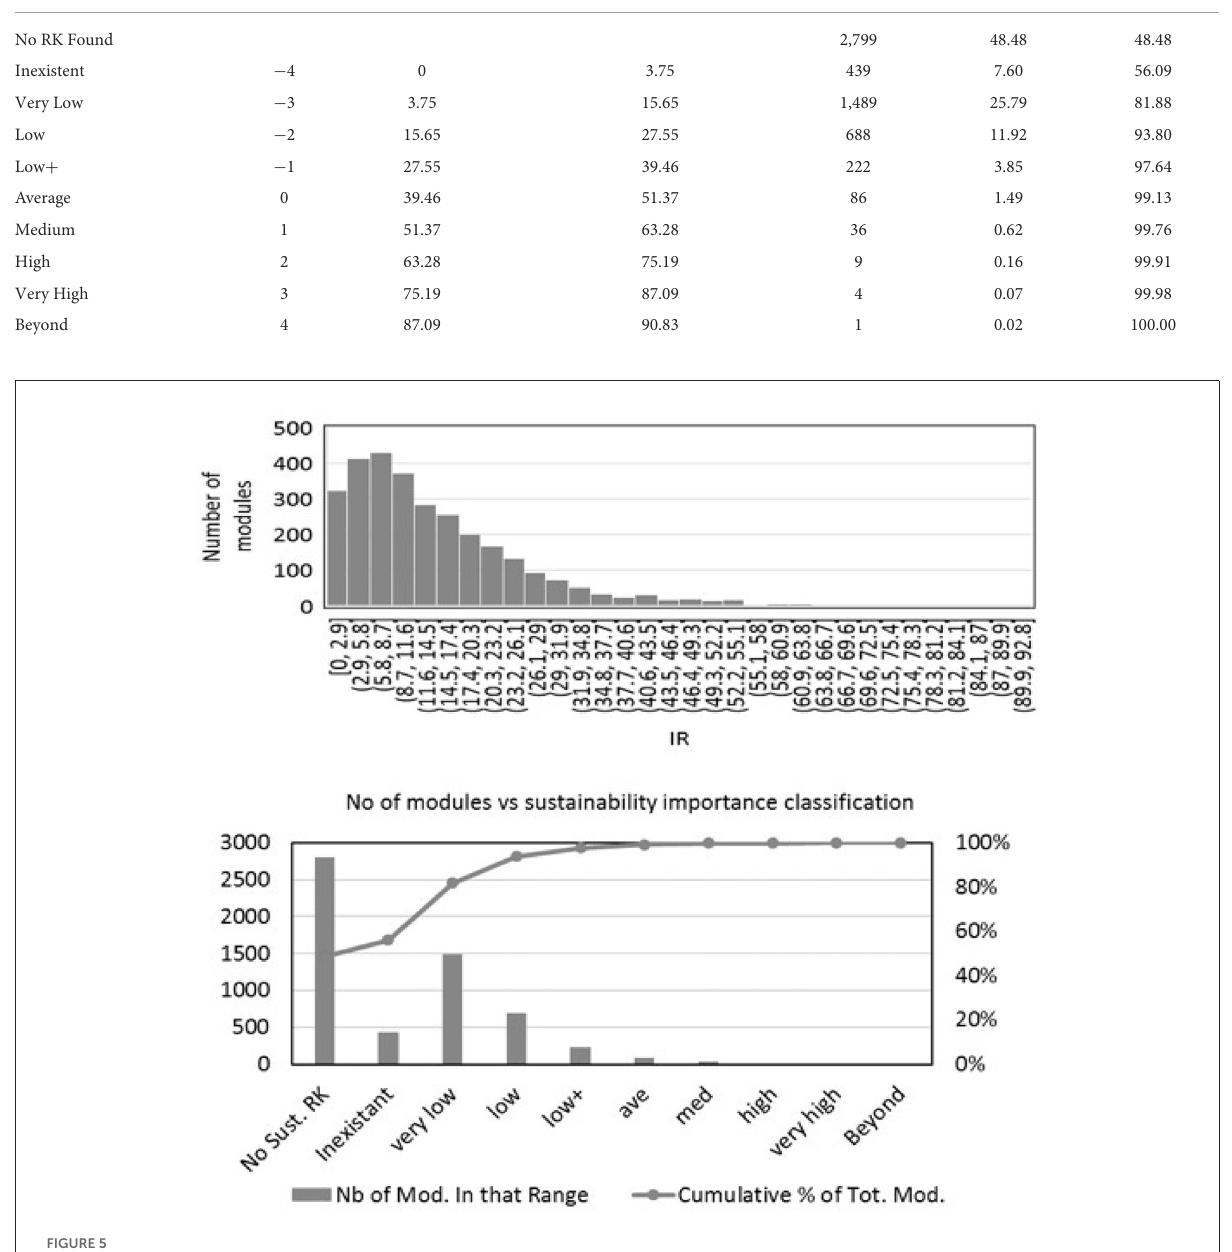
FIGURE5 Distribution of modules/courses across the importance ranges